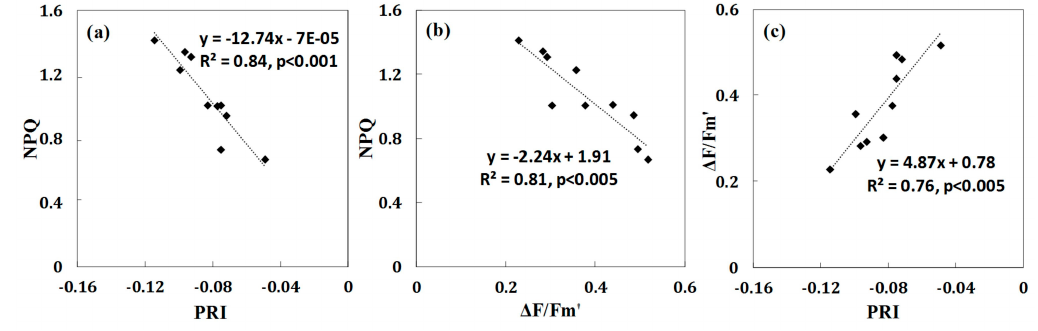
Figure 4. ( a ) The relationships between NPQ leaf and PRI, ( b ) NPQ leaf and Δ F / F m ′ and ( c ) between PRI and Δ F / F m ′ at different soil moisture levels.